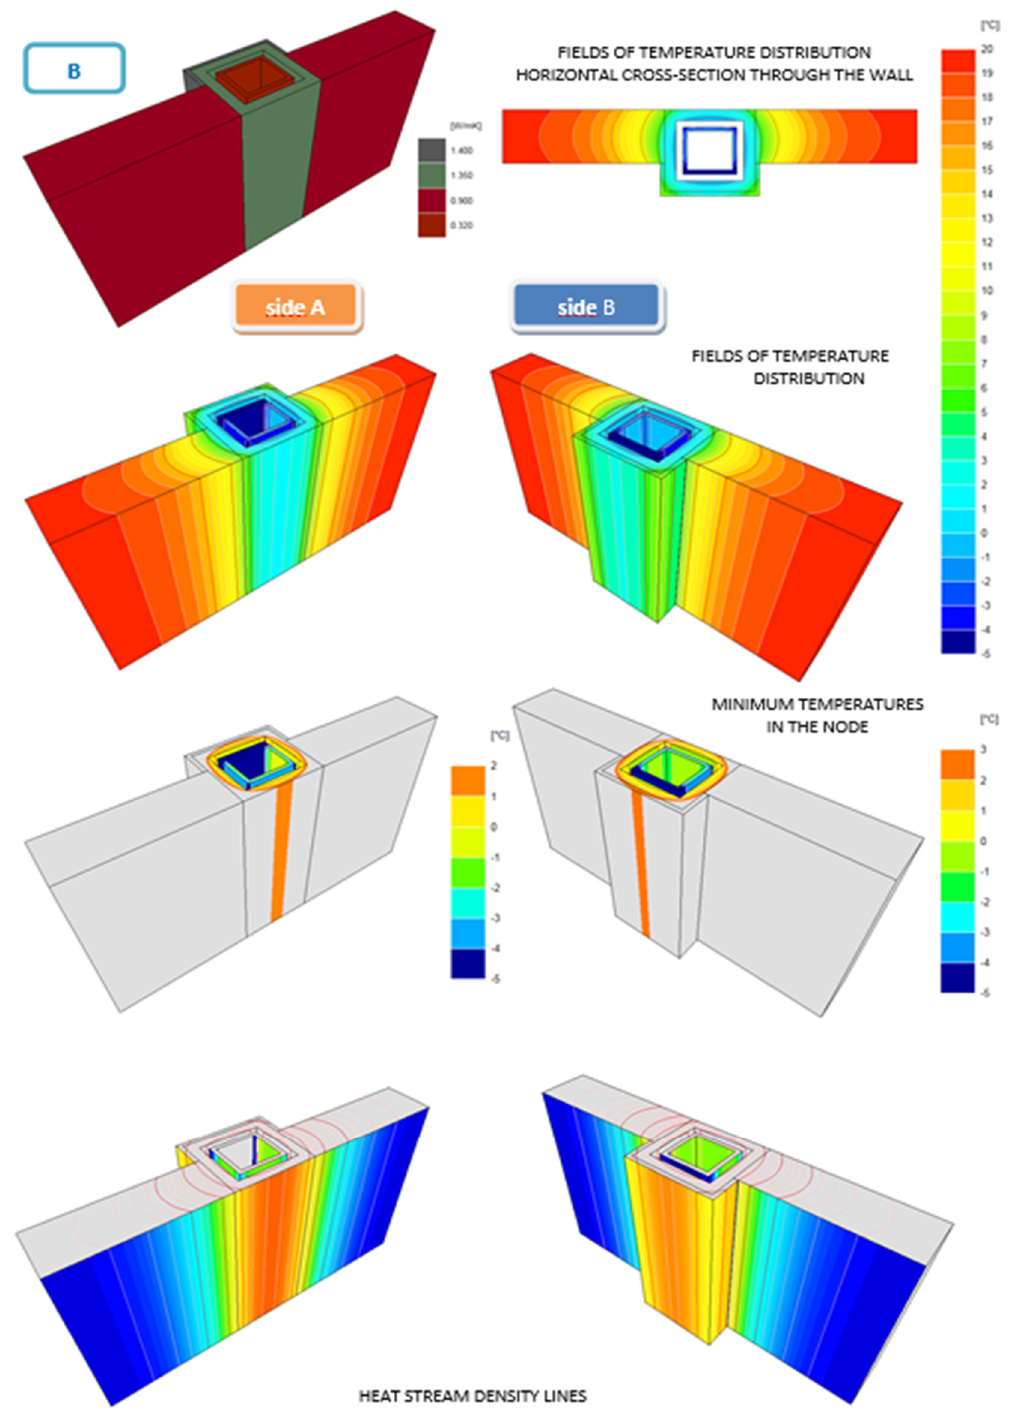
Figure A2. Scheme B: isotherm field distribution, minimum surface temperature, and heat flux distribution.